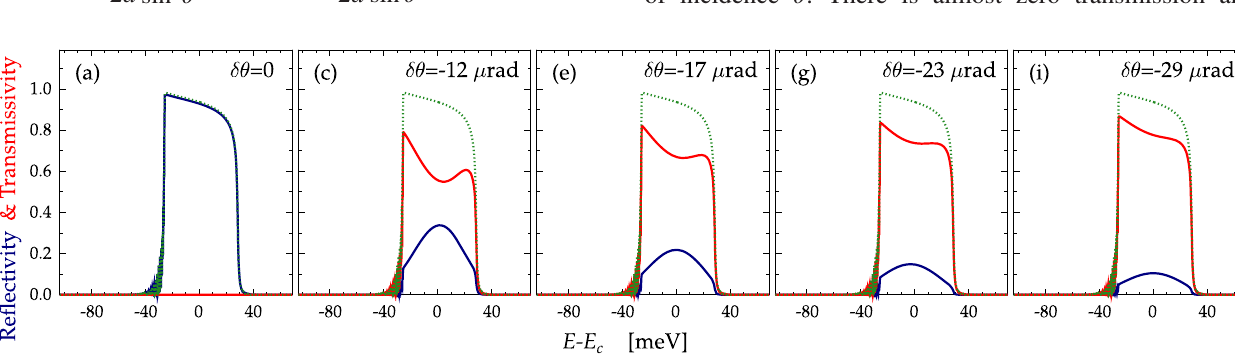
FIG. 5. Spectral profiles: (dotted green) of the radiation in the diamond four-crystal cavity upon successive (400) Bragg reflection from 300 - μ m-thick diamond crystals A → B → C → D with the central cavity energy E out of the cavity with a beam-splitter crystal in the Bragg-case geometry; (red) of the radiation transmitted through the beam splitter and left in the cavity. The beam splitter is a 15 - μ m-thick diamond crystal set in the (111) Bragg reflection at incidence angles θ ¼ ˜ θ ¼ 25 ( . 6434 °) as in Fig.